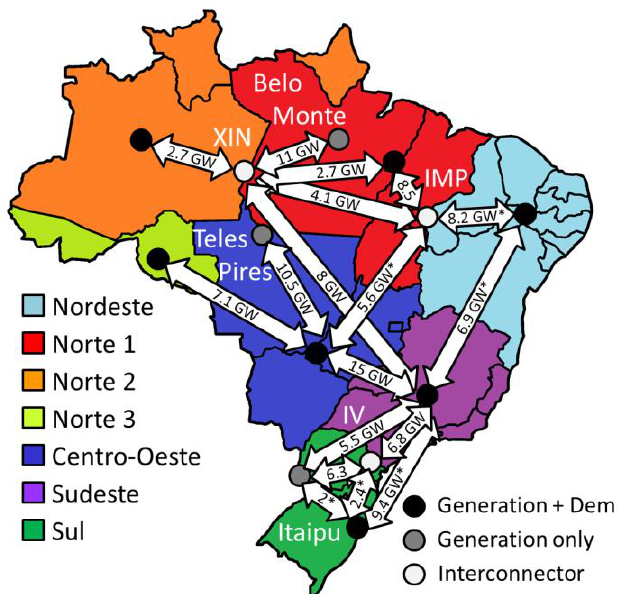
Figure 3. Map showing model regions, net transfer capacities of existing grid connections in GW, and major hydroelectric plants Belo Monte, Teles Pires and Itaipu. Connections marked with an asterisk (*) have different transfer capacities depending on the direction of power flows (Table A2).